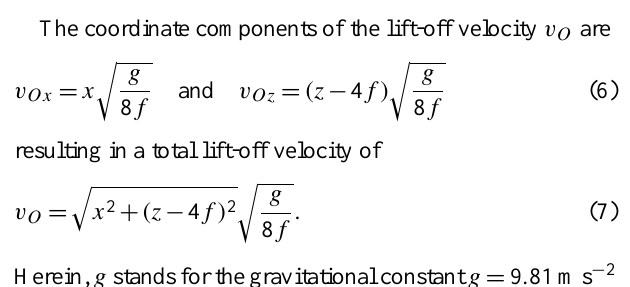
5 Structural countermeasures